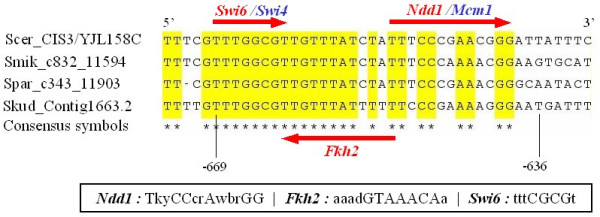
Alignment of 4 orthologous 1 kb promoter regions for CIS3 and TF binding sites. We show only the region (-636 to -669 upstream of the TSS) which contains conserved binding sites for all predicted regulators (Swi6, Fkh2 and Ndd1). We used the six-species alignment from SGD (including S. mikatae, S. paradoxus and S. kudriavzevii), but removed from the SGD output S. castellii which is more distant, and S. bayanus which has a small intergenic region of only 30 nucleotides. Consensus motifs of the TFs from Harbison et al. are shown in the box using the IUPAC code. We denote degenerate binding sites of Swi4 and Mcm1 in blue. See the main text for more details.